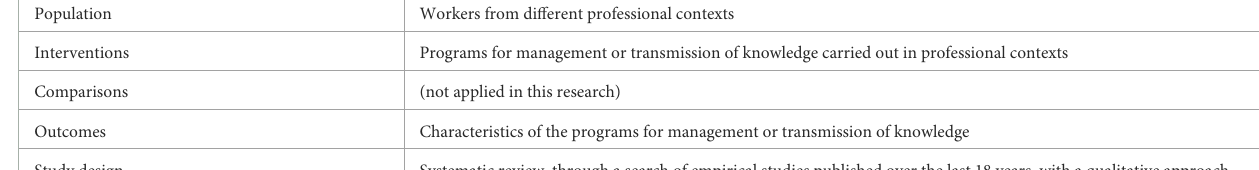
TABLE 1 PICOS approach applied to the systematic review. Population Workers from different professional contexts